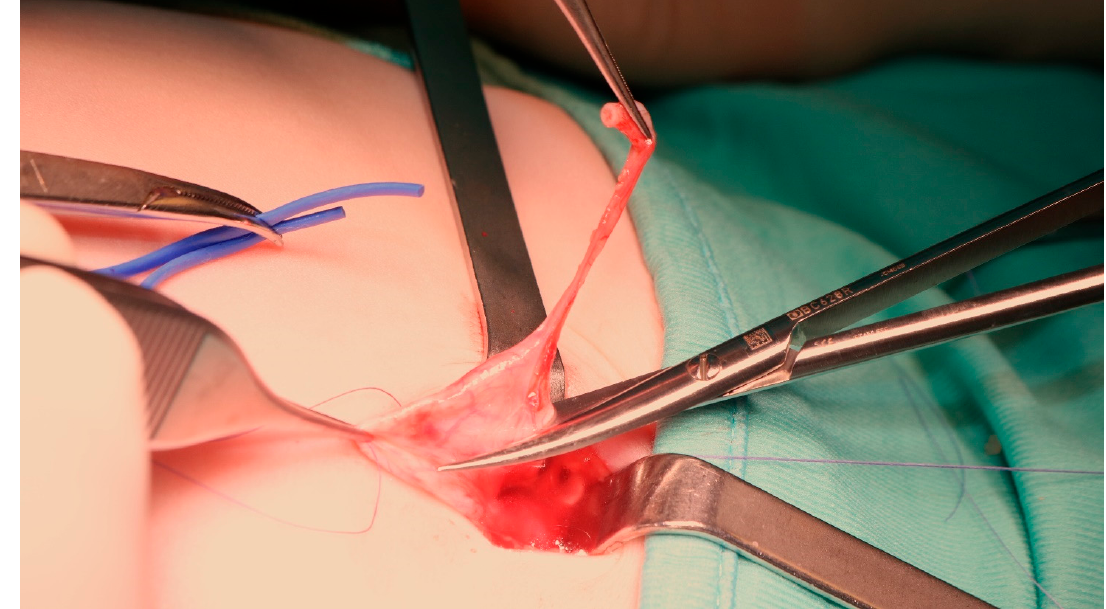
Figure 4. The obstructed UPJ with part of the dilated pelvis and proximal ureter are removed.